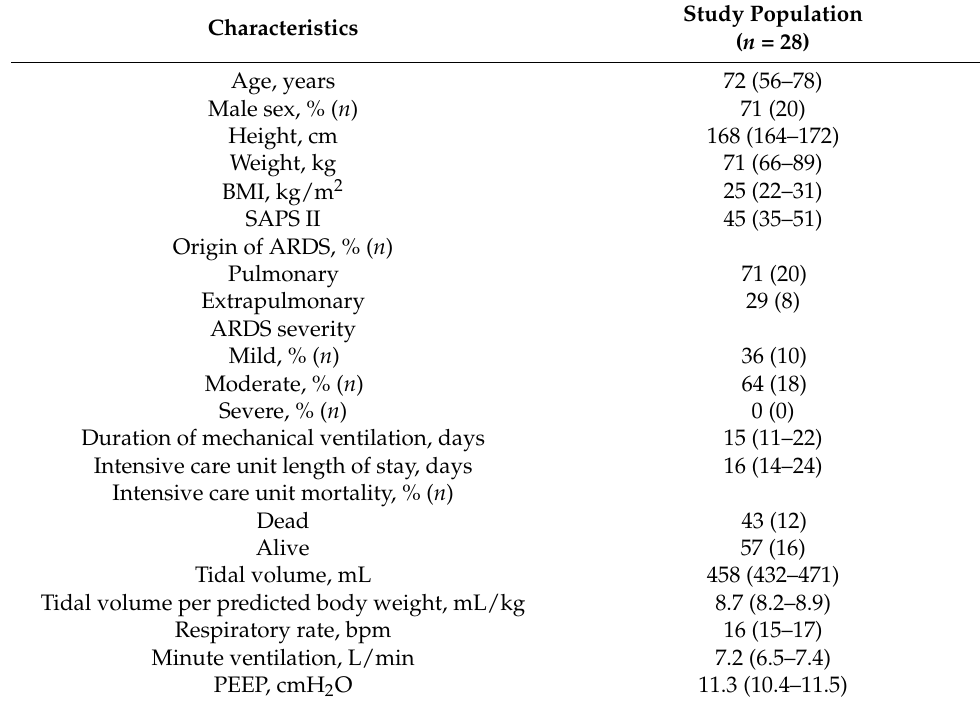
Table 1. Characteristics of the study